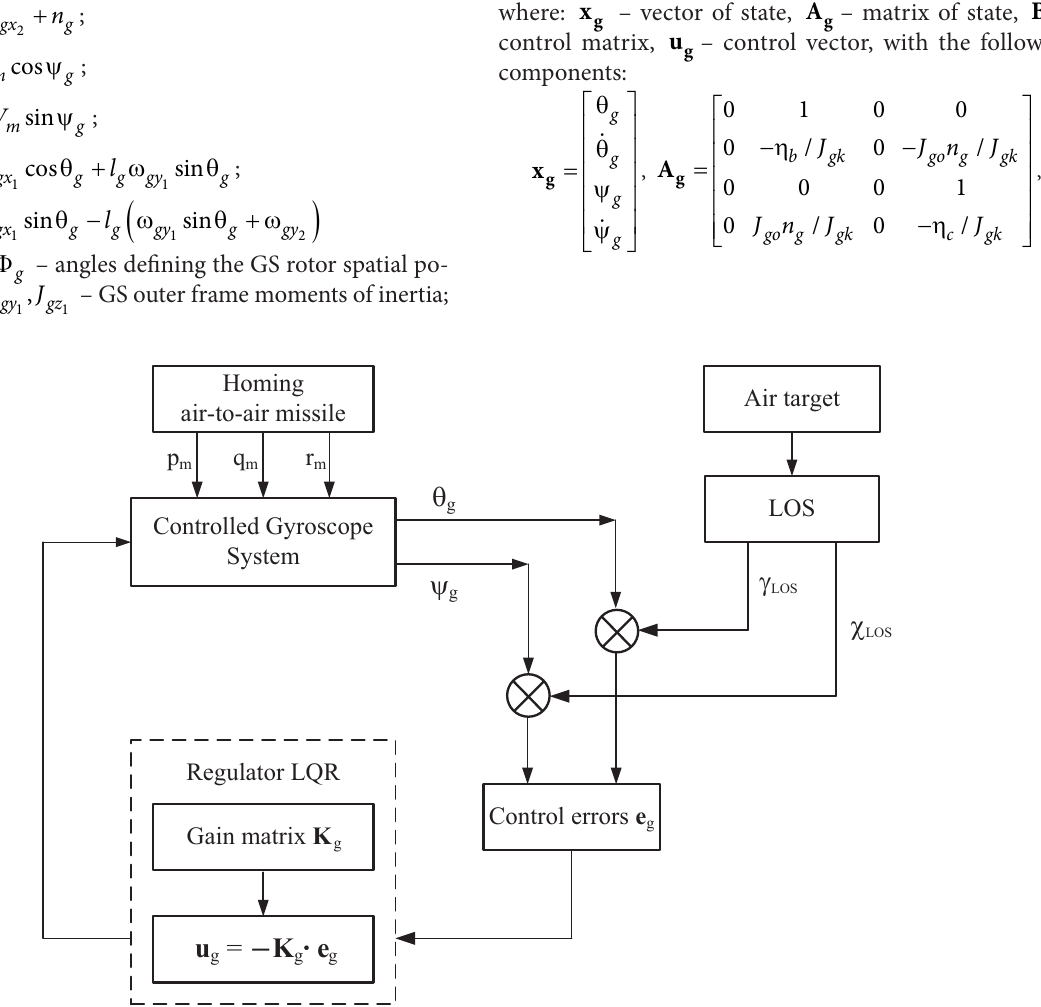
Figure 3. Diagram for the determination of optimal